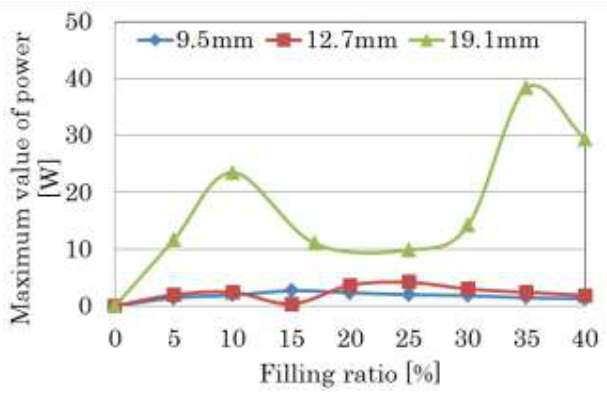
Figure 10. Maximum value of power imparted to side wall by particle in Figure